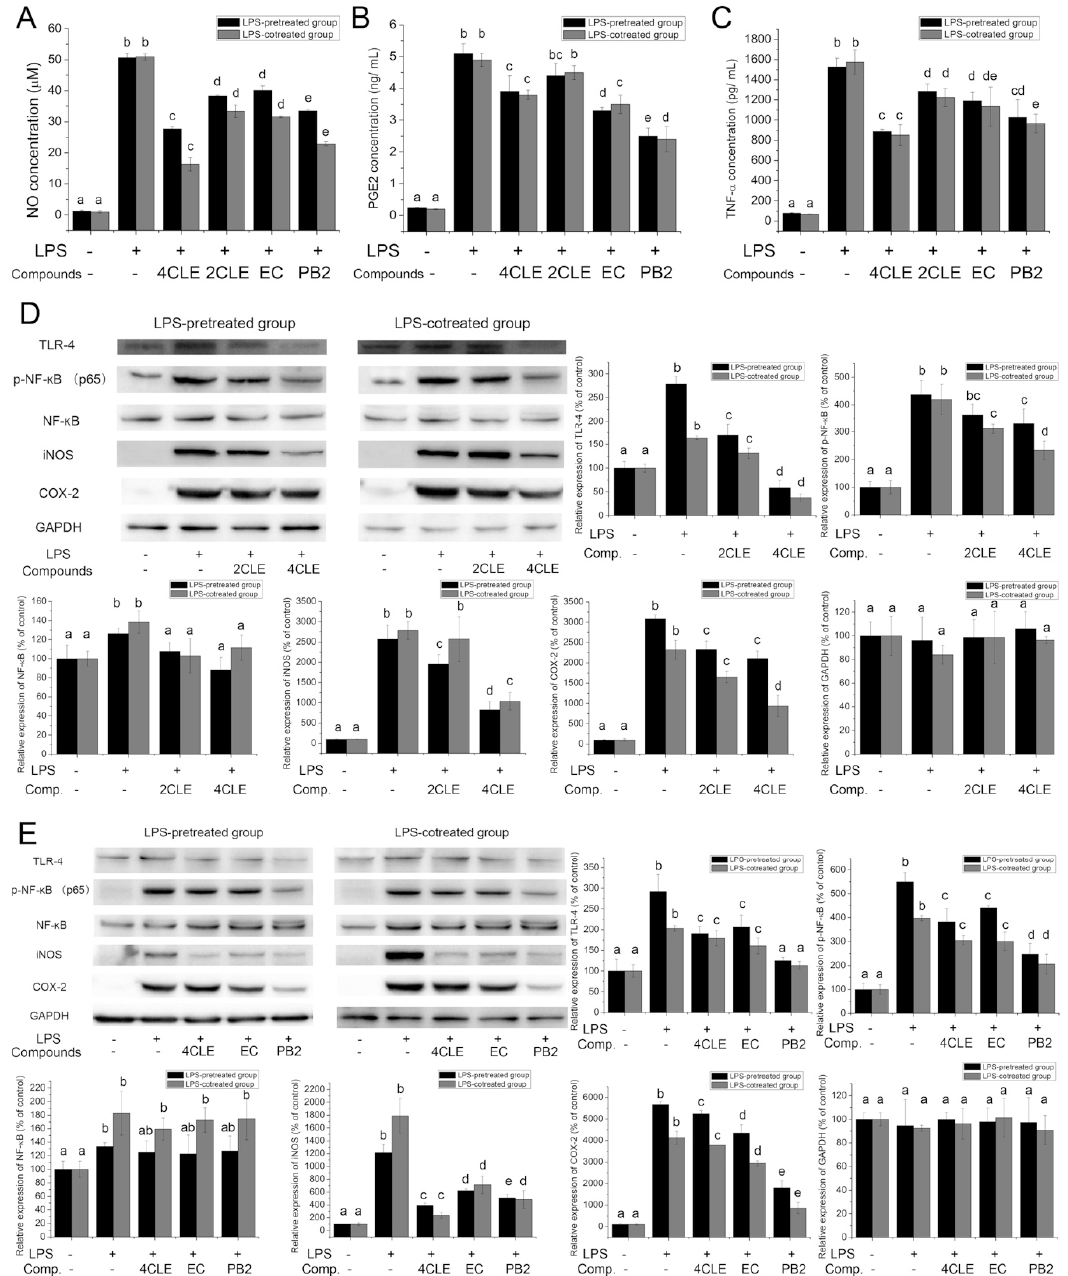
Figure 3. Anti-inflammatory activities of CLE, EC, and PB2. ( A – C ) The effects on nitric oxide (NO), prostaglandin E2 (PGE2), and tumor necrosis factor α (TNF-α) secretion of LPS-pretreated or co- treated RAW 264.7 cells; ( D , E ) The impacts on the expression of toll-like receptor 4 (TLR4), p-NF-κB (p65), NF-κB (p65), inducible nitric oxide synthase (iNOS), and cyclooxygenase-2